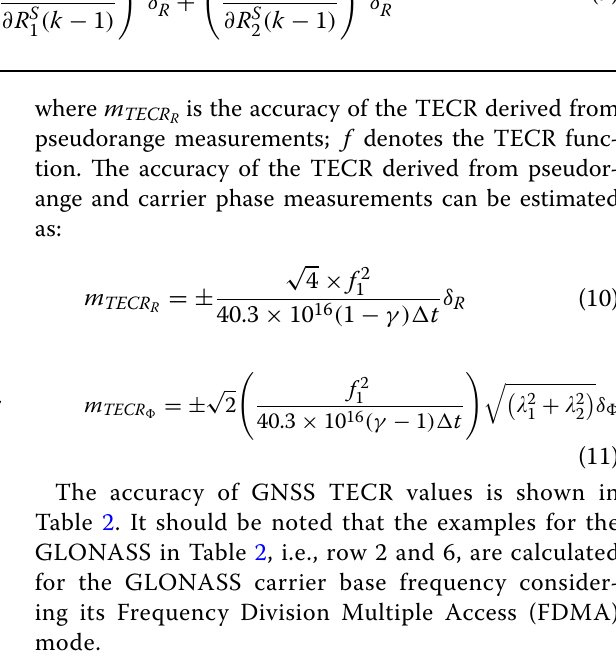
Table 1 Typical accuracy of pseudorange and carrier phase measurements of typical receiver models from major GNSS receiver manufacturers Receiver type